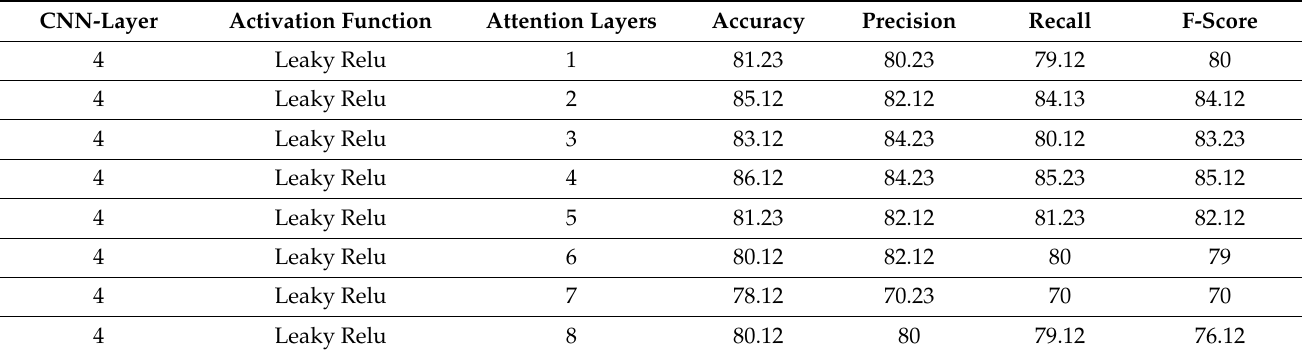
Table 3. Leaky ReLU performance with different attention layers.